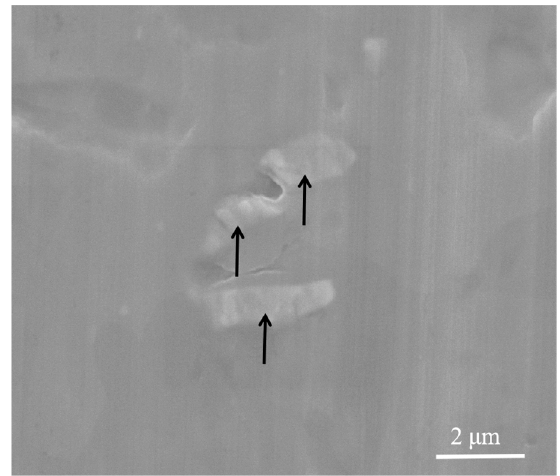
Figure 1. The surface micro-morphology of 1235 alloy foil.